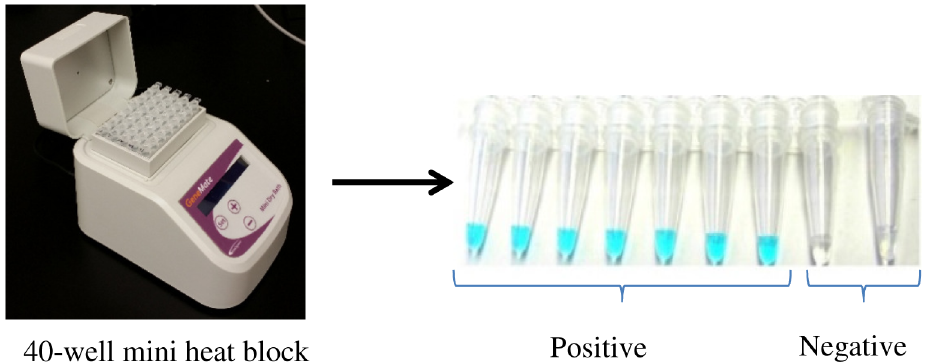
Fig 1. Expected results for the MG-LAMP